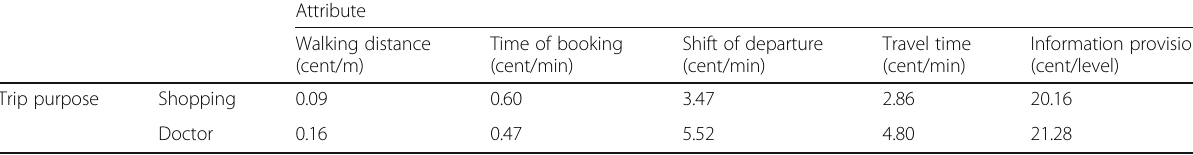
Table 5 Willingness to pay (WTP) estimation of the five non-monetary attributes according to trip purpose